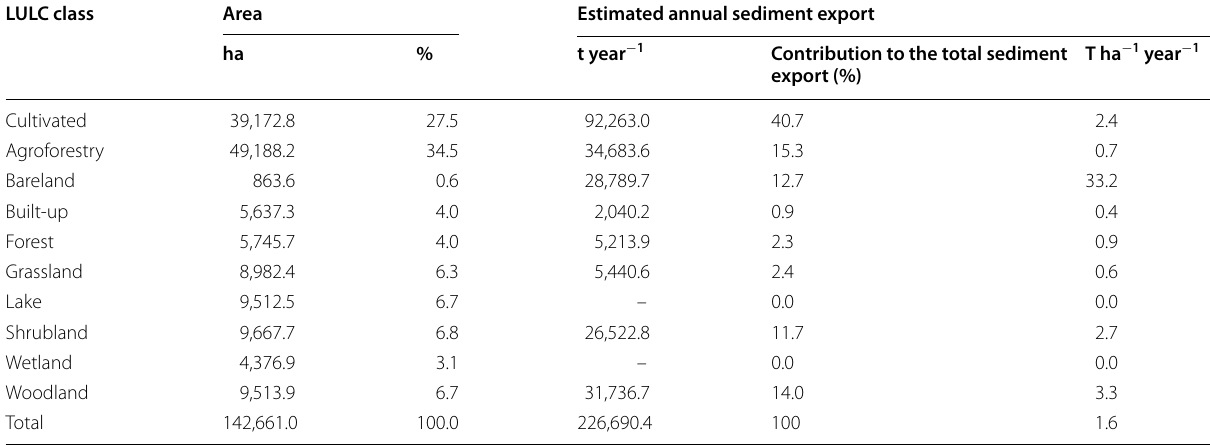
Table 12 Sediment export by LULC types LULC